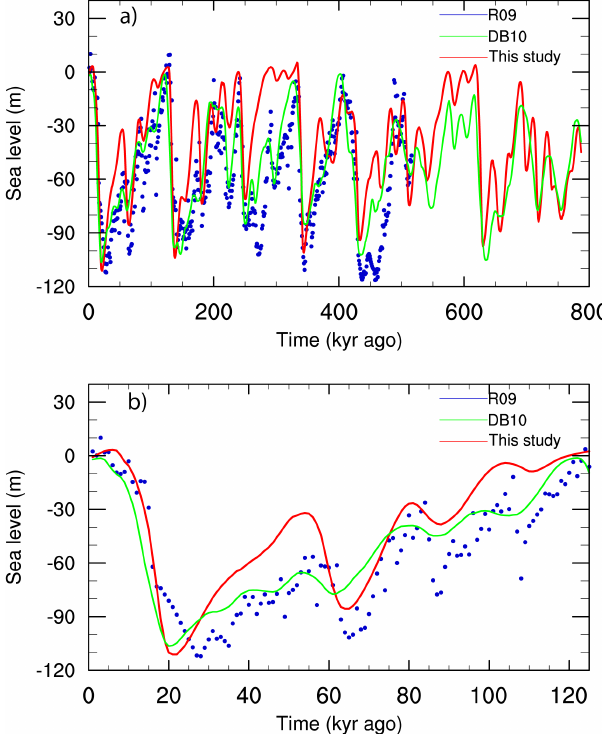
Figure 4. Modelled reference sea level relative to PD (red), com- pared to data from Red Sea sediments (Rohling et al., 2009, blue dots) and model output from De Boer et al. (2010) (green) for the past 800000 years (a) and the past 125000 years (b)